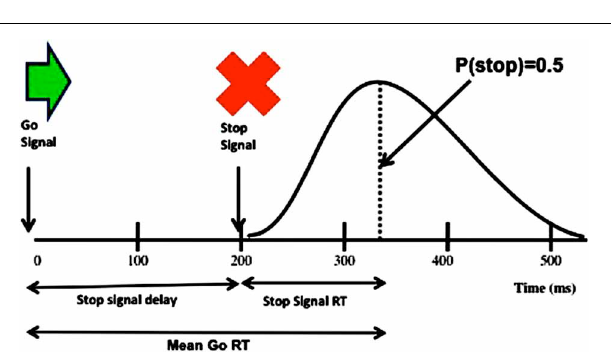
FIGURE 5 | Schematic representation of the stimuli on the stop signal task (upper part) and also showing the reaction time (RT) distribution and how the stop signal reaction time (SSRT) is derived as the difference between mean Go RTs and the average stop signal delay (SSD) at the point when responses are successfully inhibited on 50% of the trials (lower